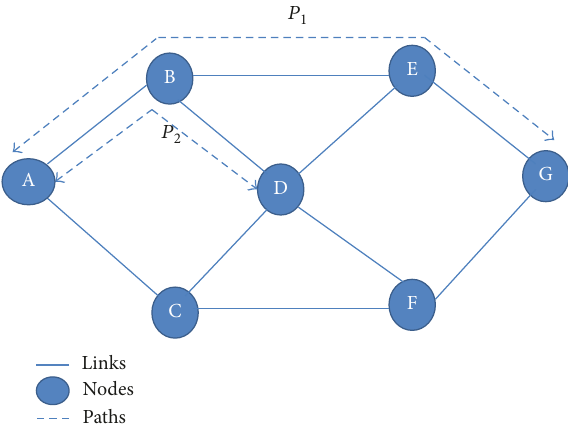
Figure 1: An architectural depiction of a communication or com- puting network model with 7 nodes, 10 links, and 2 paths